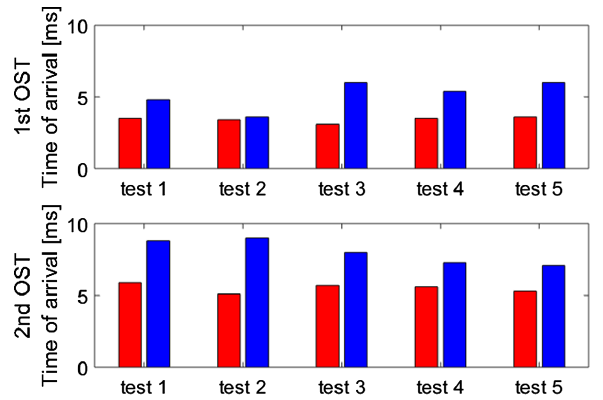
FIG. 6. Oscilloscope signals from OSTs during cavity quench at different temperatures. Horizontal: 4 ms = division. Vertical. RF Signal: 10 mV = div; 2nd and 3rd OST: 100 mV = div; 1st OST: 1 V = div.(1.71K), 500 mV = div.(1.9,2.03K), 100 mV =